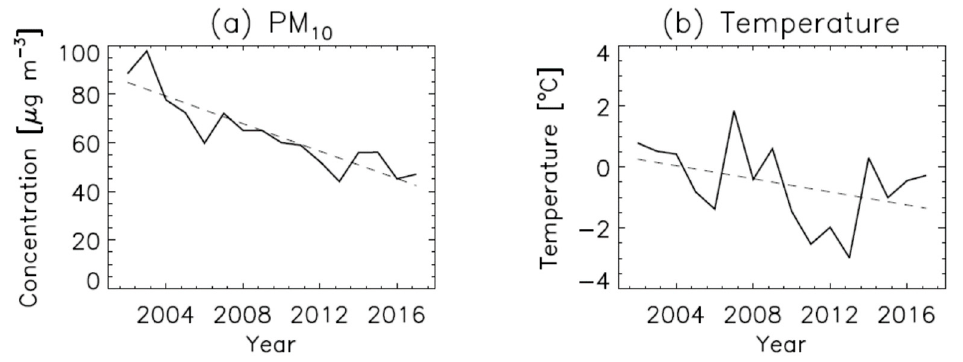
Figure 3. Seasonal averaged time series of ( a ) the surface PM 10 (left panel) and ( b ) the surface temperature (right panel) over Seoul in winter. Units are µg m − 3 and ° C, respectively.